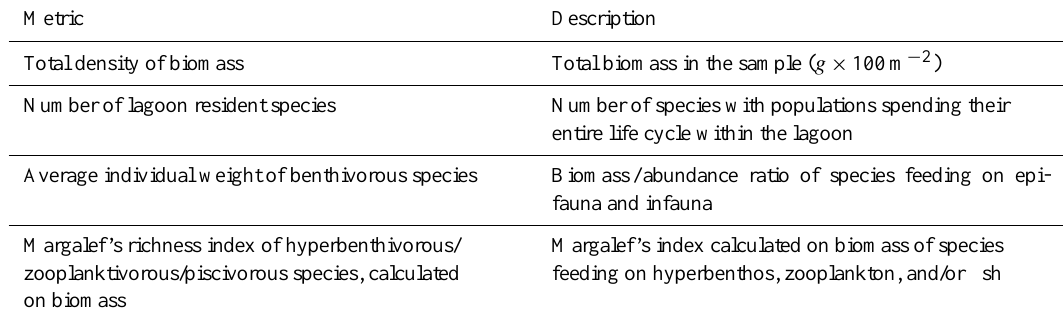
Table 1. Description of the four metrics selected for the development of the habitat fish bioindicator index for the Venice lagoon.